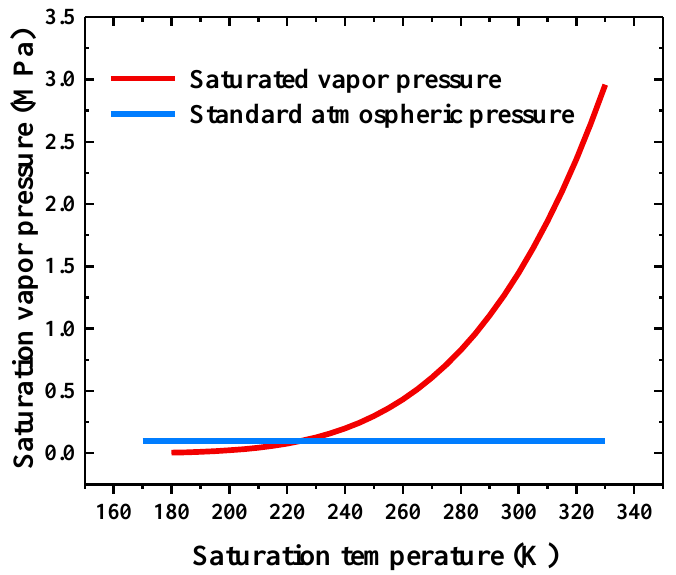
Figure 3. The saturated vapor pressure versus saturation temperature of HFC-125.